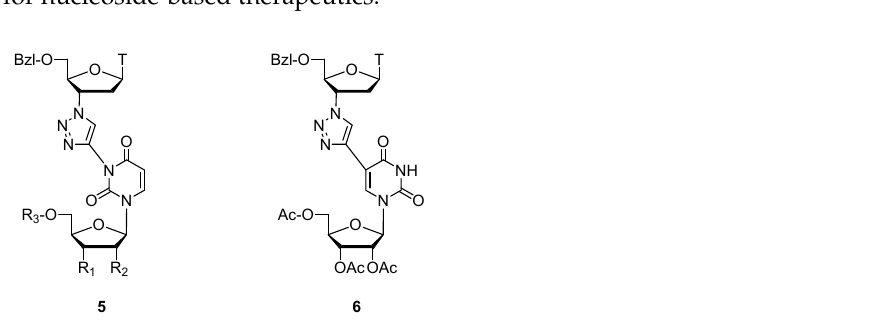
Figure 5. N -3 or C -5 branched nucleoside dimers containing a 1,2,3-triazolyl linkage.